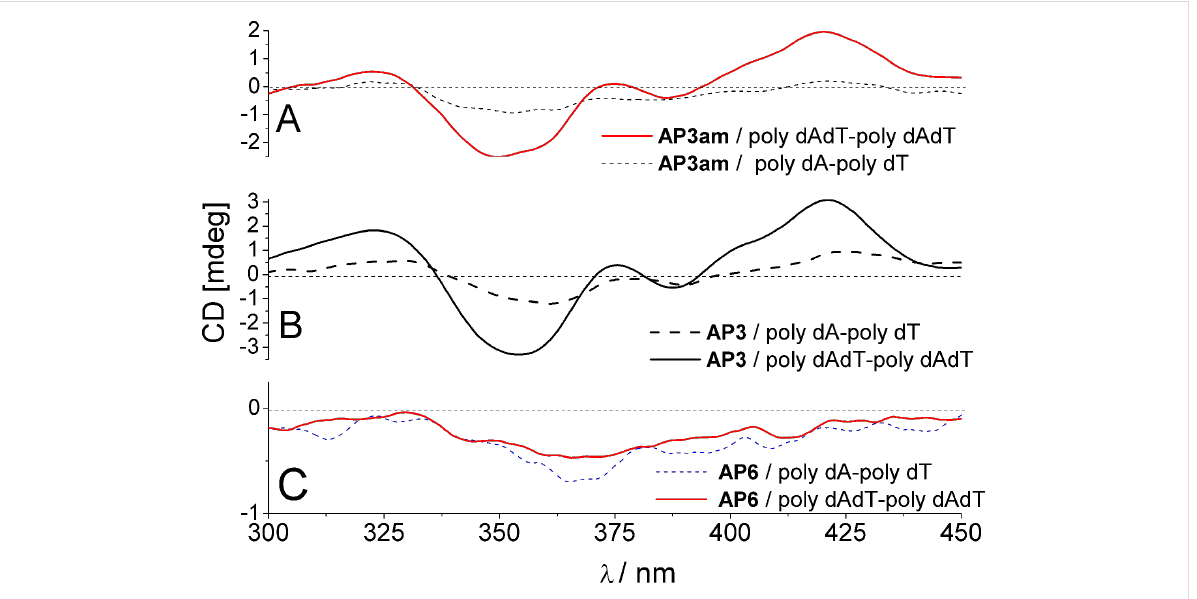
Figure 2: Induced CD bands observed for AP3 , AP3am , AP6 for poly dA–poly dT and poly (dAdT) 2 ( c = 3.0 × 10 − 5 mol dm − 3 ). The dG–dC and rA–rU polynucleotides did not give any induced (I)CD bands >300